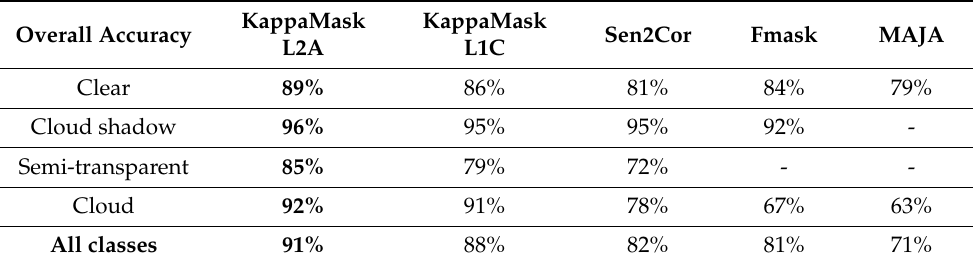
Table 5. Overall accuracy evaluation performed on the test dataset for KappaMask Level-2A, Kappa- Mask Level-1C, Sen2Cor, Fmask and MAJA cloud classification maps. Evaluation is performed for clear, cloud shadow, semi-transparent and cloud